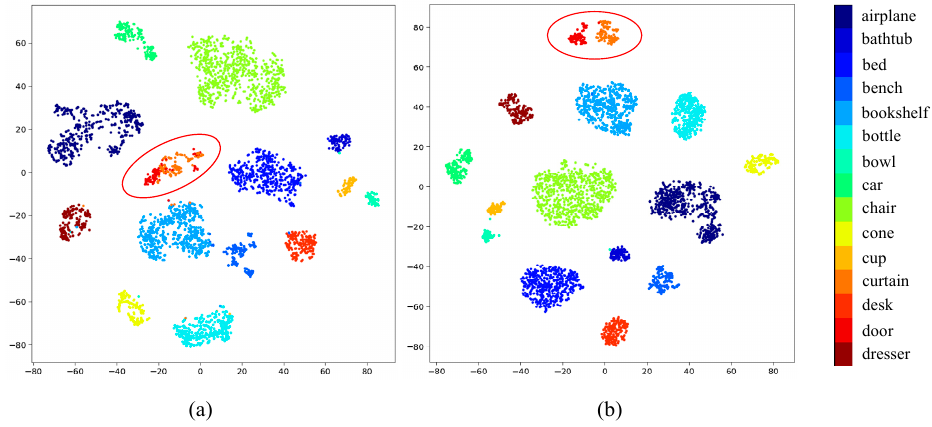
Figure 9. Visualization of the learned features on the ModelNet40 dataset using PointNet ( a ) and SAPointNet ( b ). Red circles show a typical case where two similar categories are hard to split by PointNet but show a clear difference in the feature space of our SAPointNet.